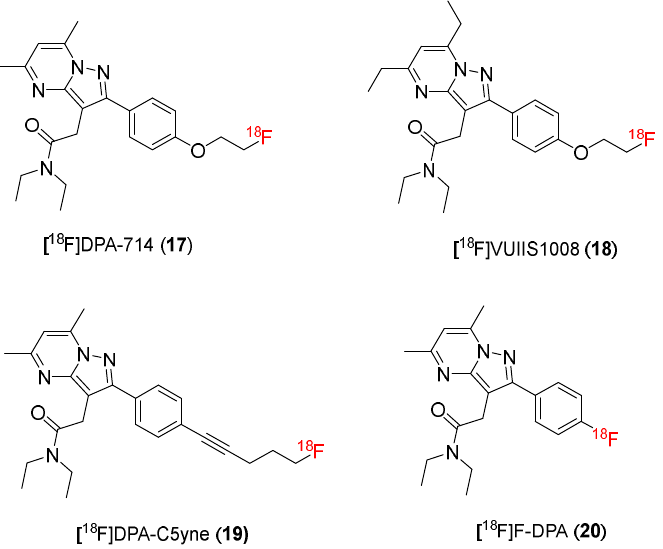
Figure 3. Structures of TSPO ligands containing pyrazolopyrimidine.